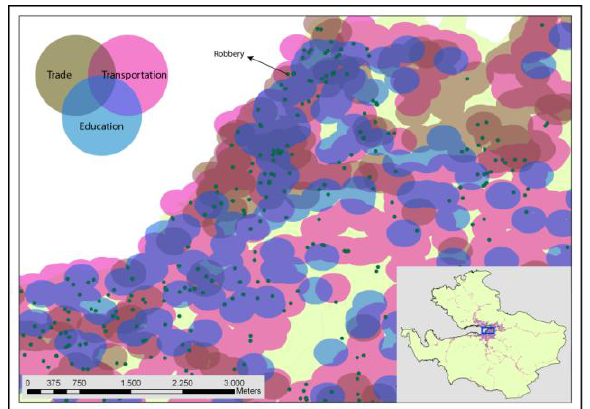
Figure 2. Overlay of robbery events with trade (banking and commercial facility locations), education and public transportation stations